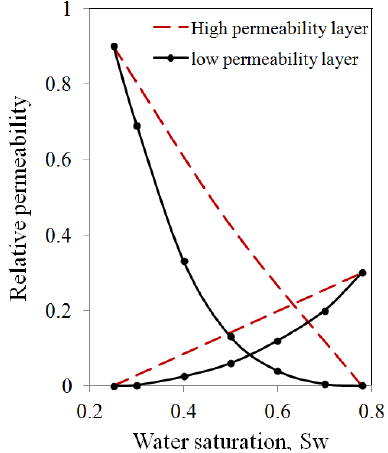
Figure 5. Relative permeability curves for low and high permeability media in two-layered reservoir.